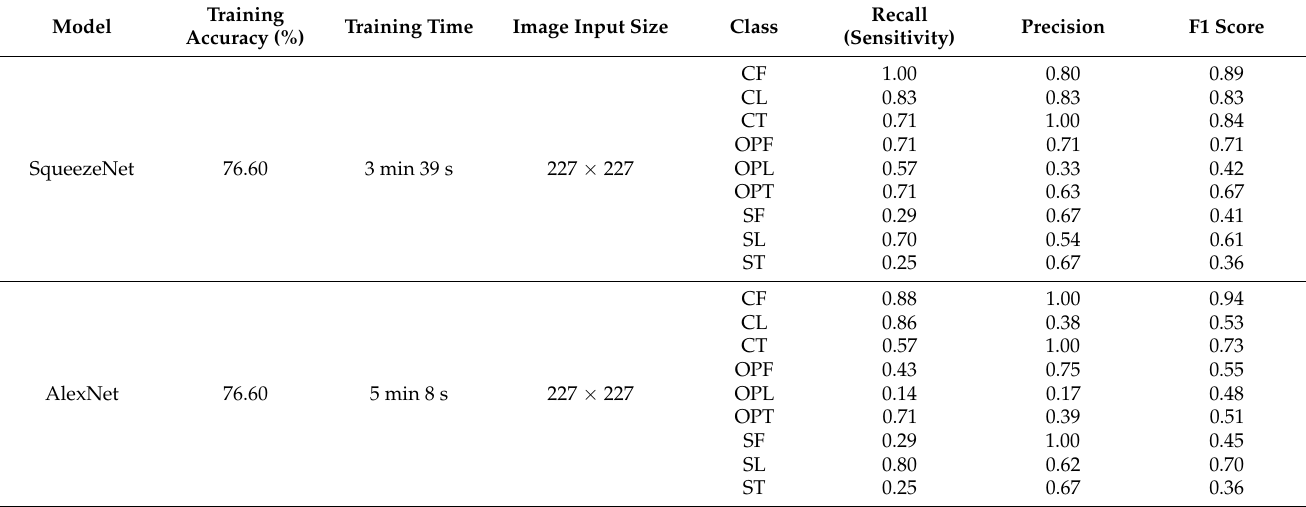
Table 5. Classification results of three networks.